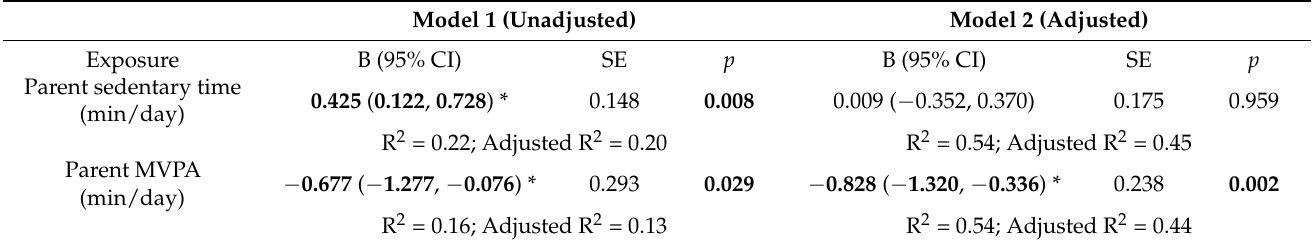
Table 4. Linear regression for the association between children’s and parents’ PA and sedentary behaviors. Model 1